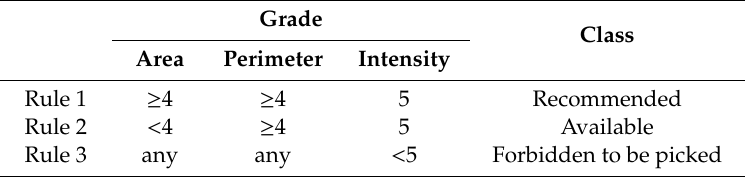
Table 16. Grading rules based on combination artificial neural network output.